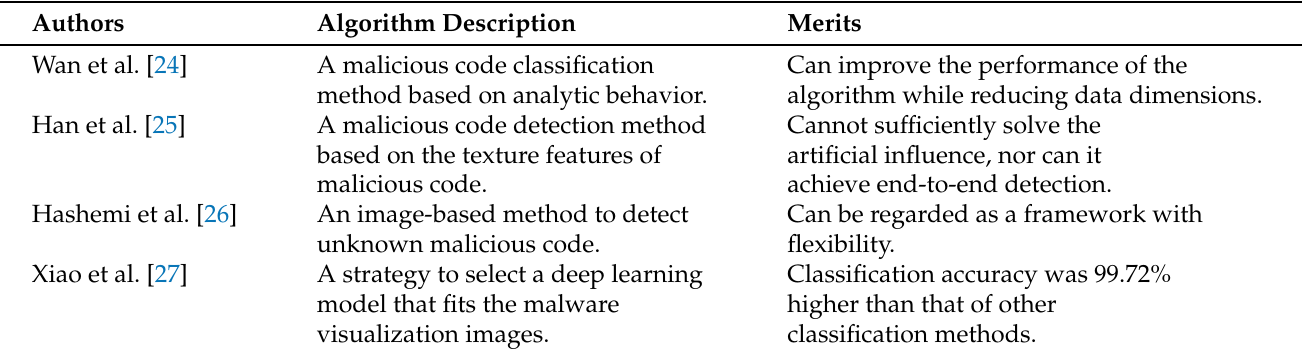
Table 3. The Image detection